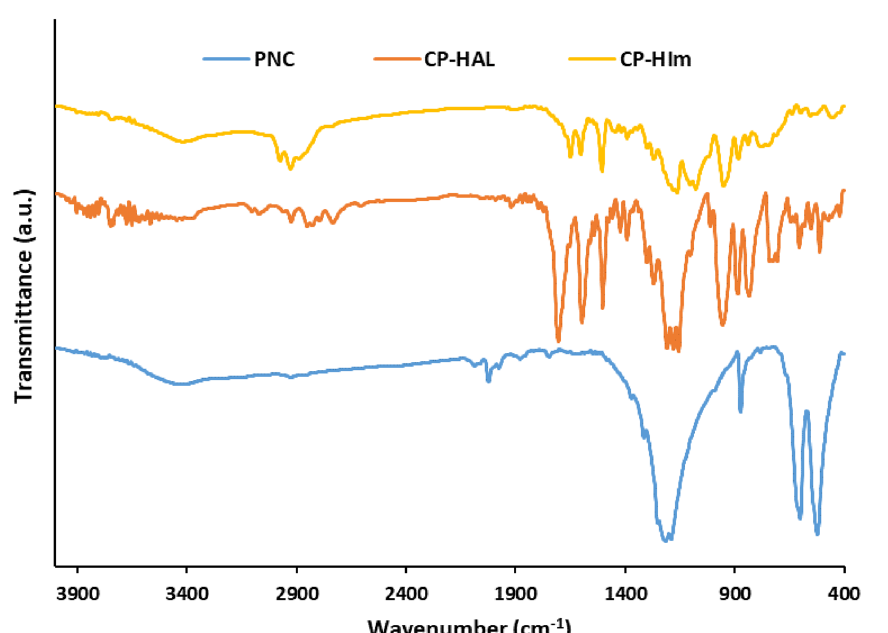
Figure 8. FTIR spectra of boehmite, PNC, CP-HAL, CP-HIm and